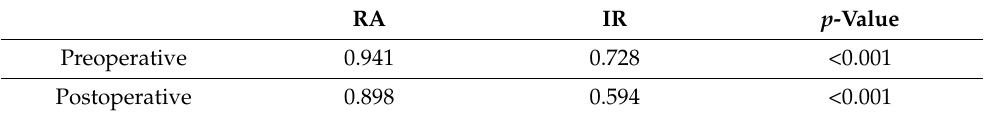
Table 2. Preoperative and postoperative interclass correlation coefficient (ICC) for raters’ average (RA) and individual raters (IR) between the six raters.